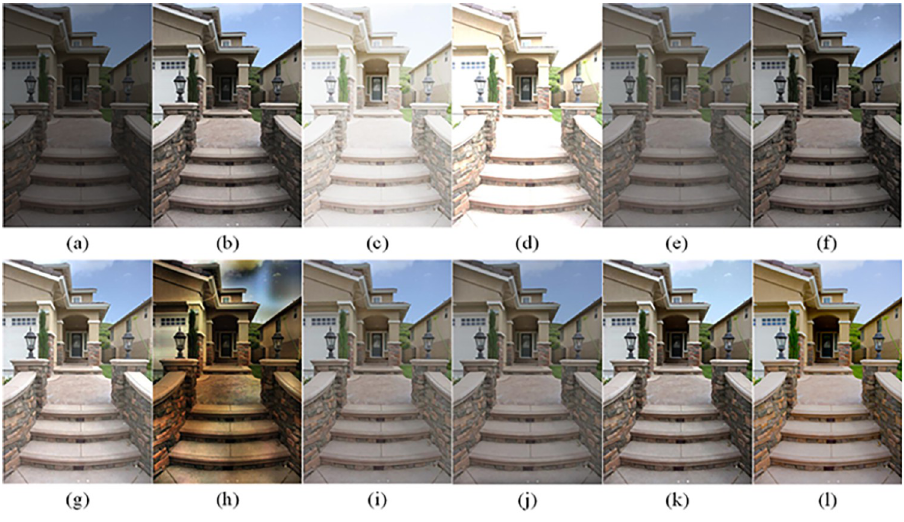
Fig 24. Comparisons of the ten algorithms in enhancing low-light image 14. (a) low-light image (b) AGCWD (c) Al-Ameen (d) BHE2PL (e) BIMEF (f) BPDHE (g) LIME (h) MSRCR (i) NPEA (j) SRIE (k) OURS (l) Normal light image.